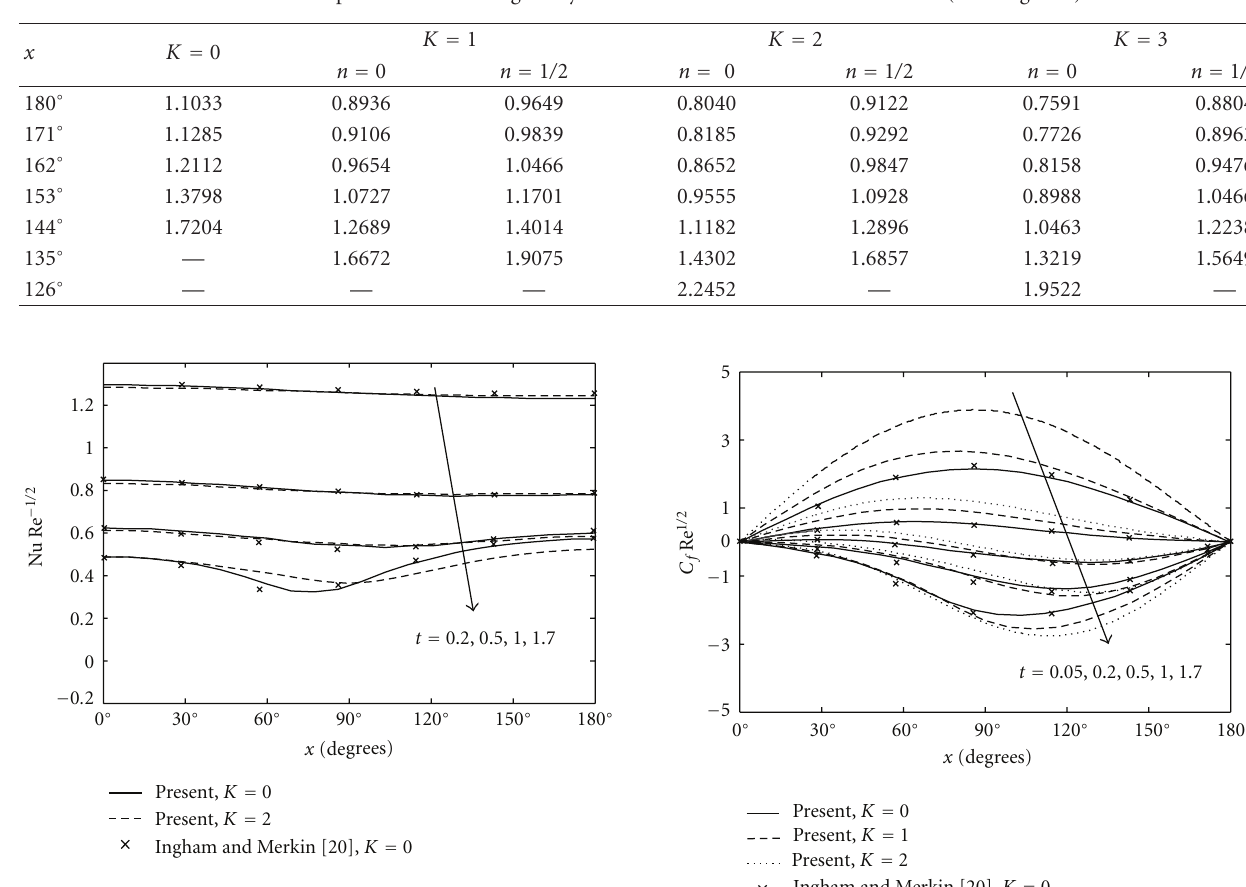
Table 3: The separation times along the cylinder surface when Pr = 7 and α = 1 . 25 (assisting flow).